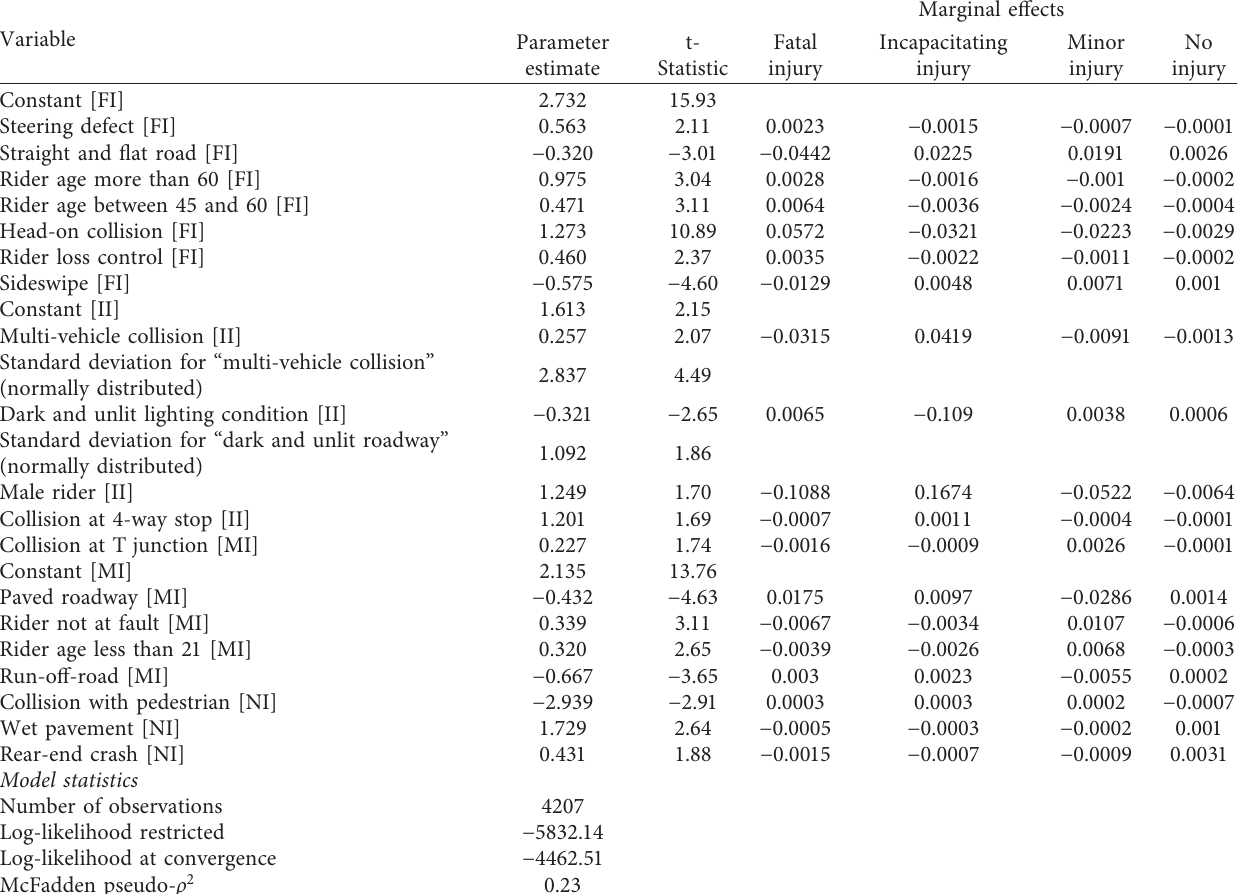
Table 3: Mixed multinomial logit model estimation results for rural motorcycle